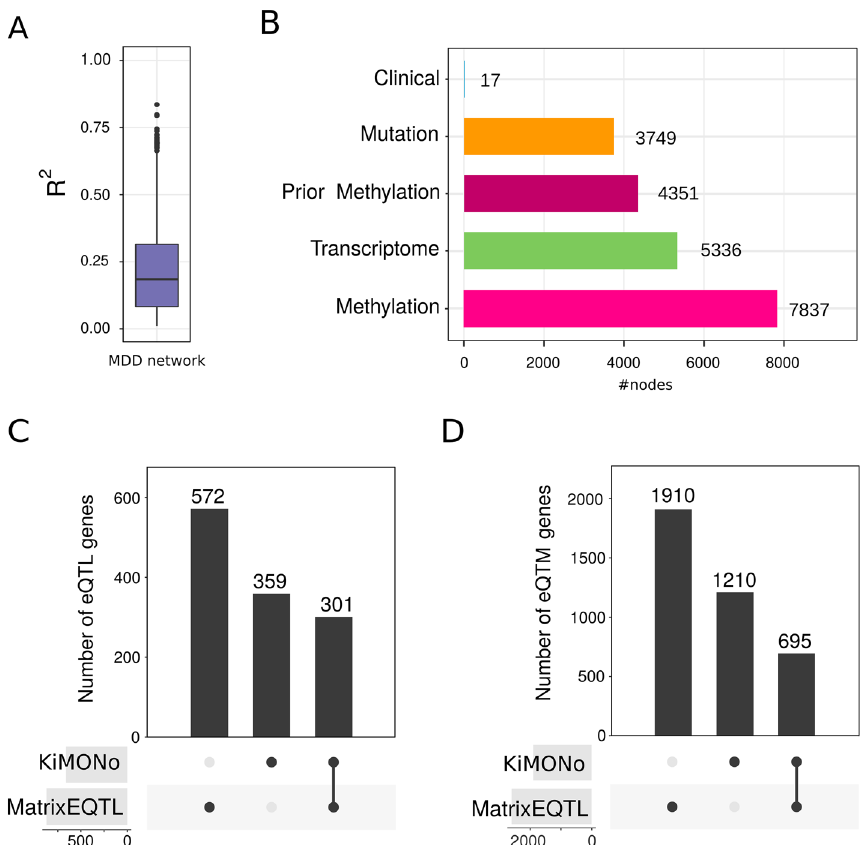
Figure 5. ( A ) MDD network Performance on all gene models n = 9943 inferred by KiMONo after filtering for − 0.02 < β < 0.02 coefficient and R 2 > 0.1 . ( B ) Composition of retained features deriving from omic levels of first-methylation and SNPs, as well as and second-order methylation, SNPs, gene expression and biological clinical features; comparison of ( C ) number of eQTL genes and ( D ) eQTMs gene derived from KiMONo and